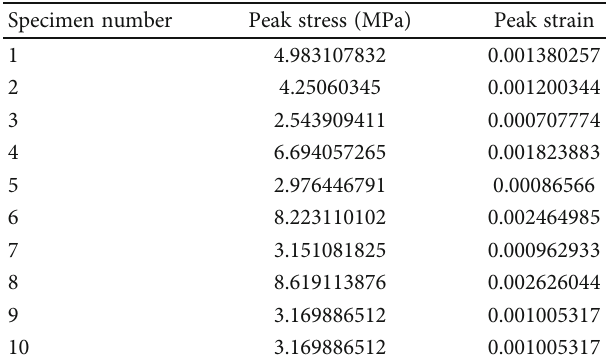
Table 2. Table 3 is the summary table of the maximum Lyapunov